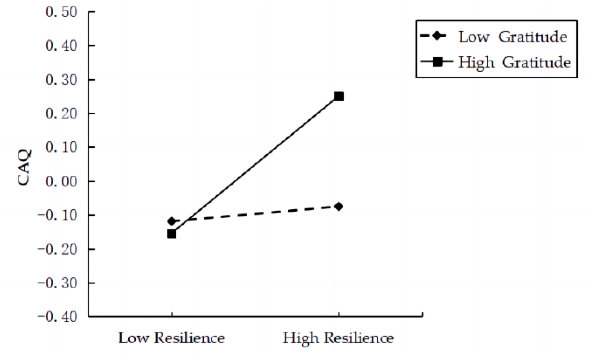
Figure 2. The moderating effect of gratitude on the relation between resilience and CAQ.